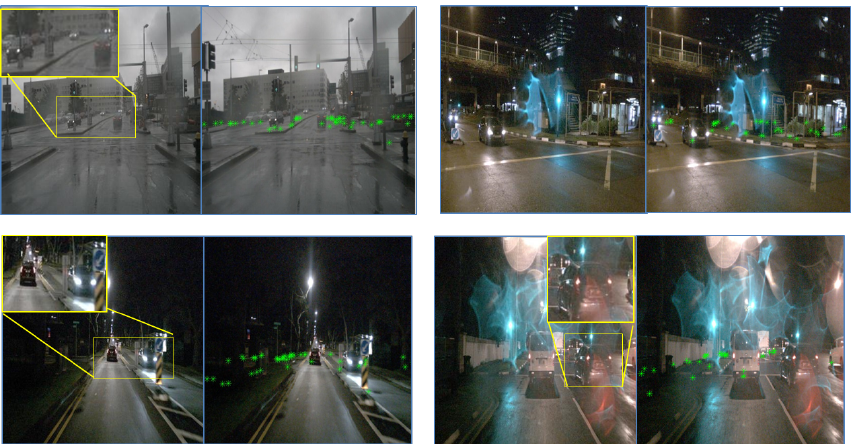
Figure 1. Scenes from the Nuscenes dataset, where radar reflection are obtained in varying conditions. The camera obtains the object boundaries in the same conditions.